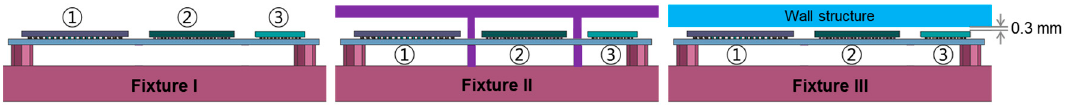
Figure 4. Schematic of three fixtures for various BGA boundary conditions.